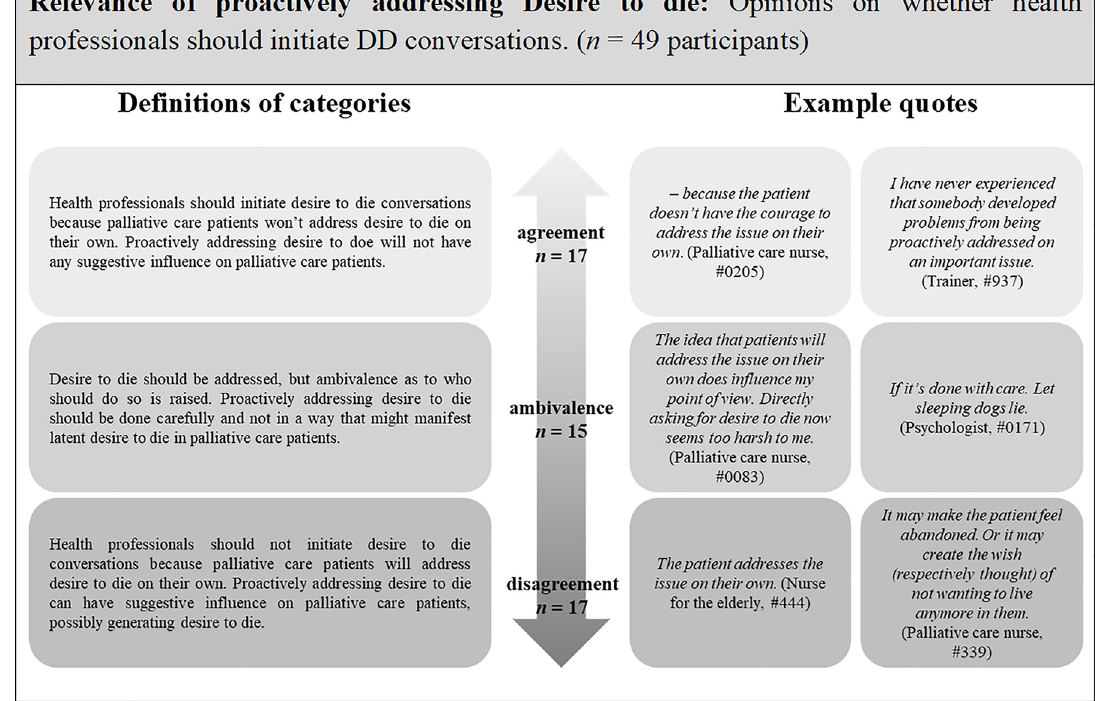
Fig 4. Evaluative category related to ‘proactively addressing desire to